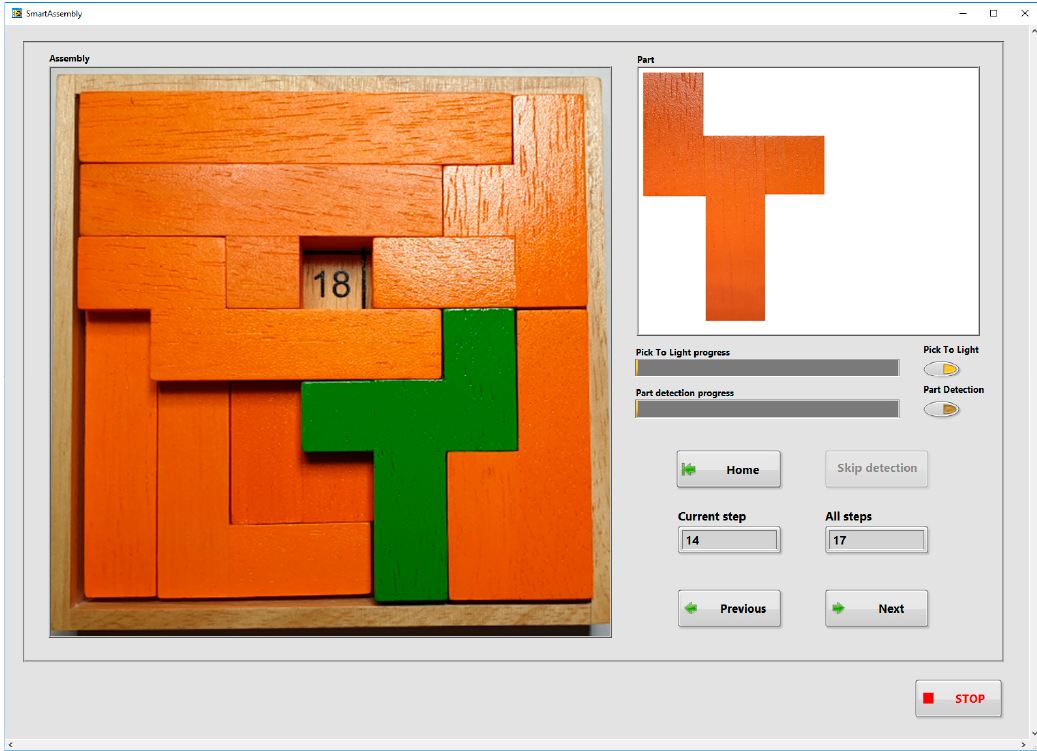
Figure 12. Main application GUI (Gillux-Puzzle, solution field 18, step 14/17).